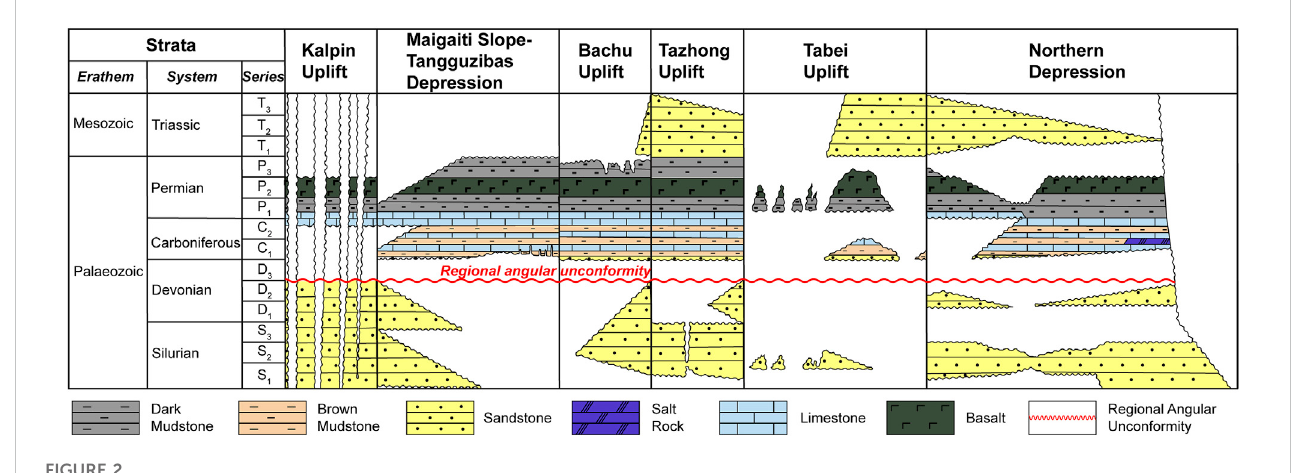
FIGURE 2 Silurian-Triassic tectonic-sedimentary evolution in the Tarim